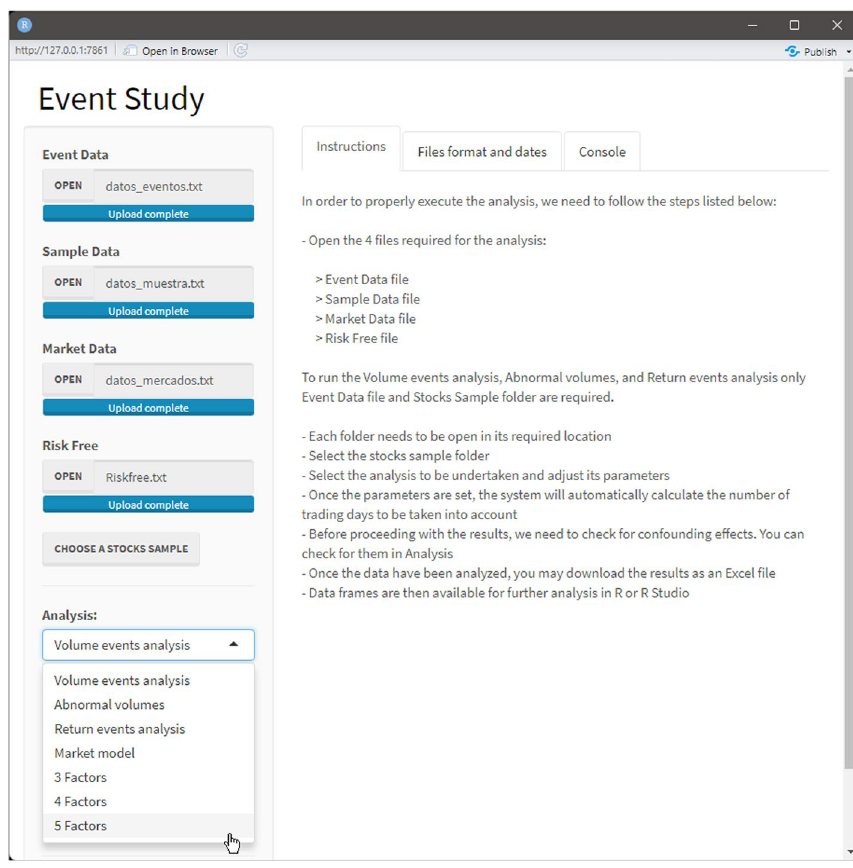
Fig. 15 Drop‑down menu. Source : Created by authors